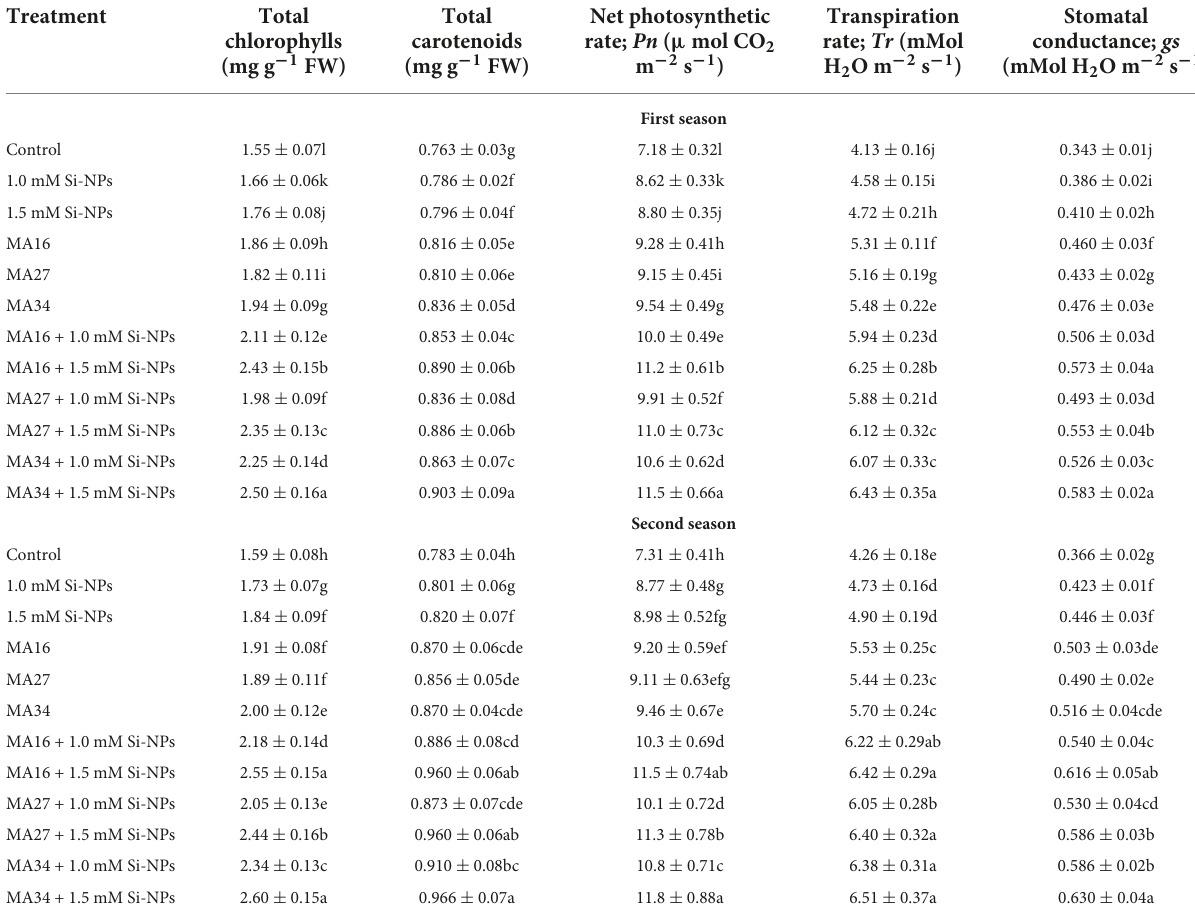
TABLE 3 Effect of soil application with calcium carbonate precipitating bacteria (CCPB), Bacillus lichenforms (MA16), Bacillus megaterium (MA27), and Bacillus subtilis (MA34), and foliar application with silicon nanoparticles (Si-NPs) on photosynthetic pigments and gas exchange of wheat plants (cv. Misr